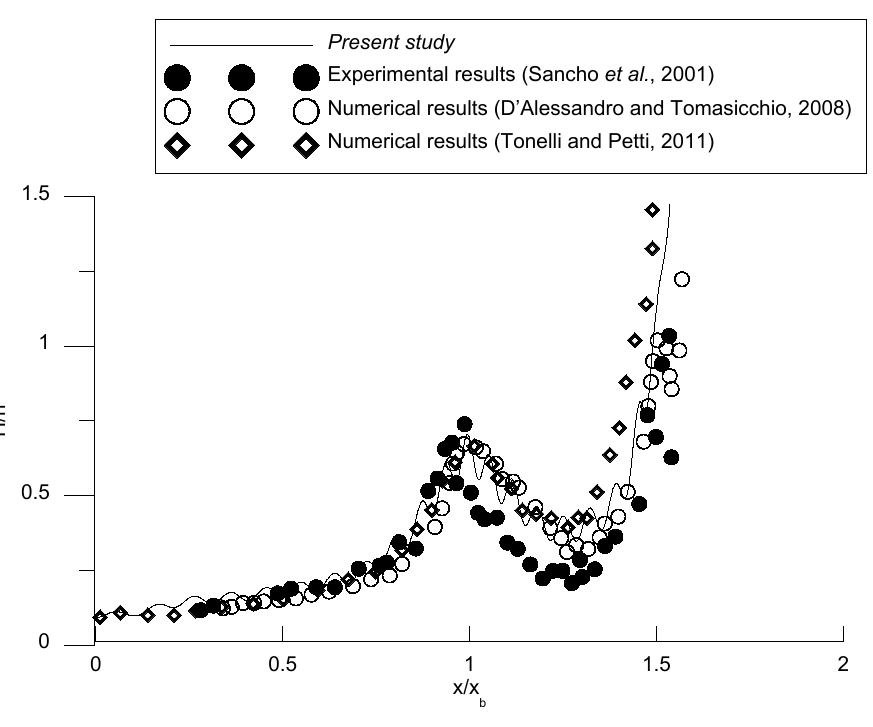
Figure 19. Comparisons of wave heights for breaking and dissipation of waves by a barred beach for the spilling breaking case [46–48].